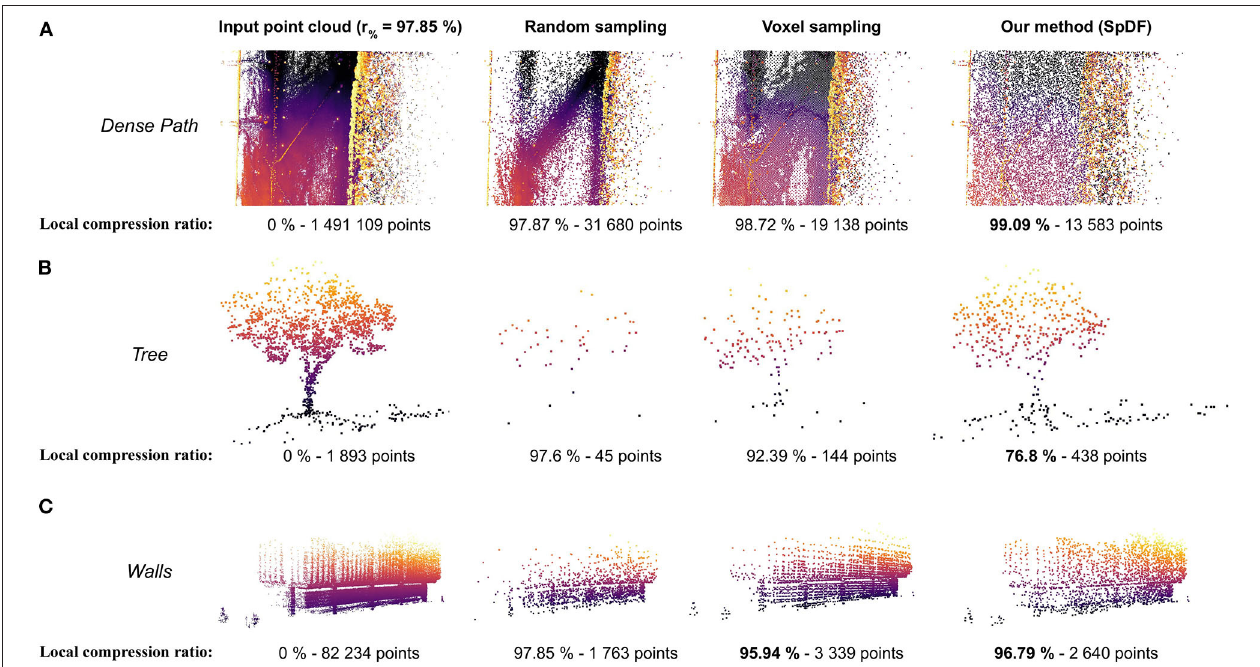
FIGURE 10 | Sub-views comparison from the Grand Axe map, containing more than 4.65 million points with varying densities. The whole point cloud has been sampled to 100 k points (i.e., a compression ratio of 97.85 %) by Random sampling, by Voxel sampling and by our method, SpDF . Local compression ratio has been reported for each sub-view. (A) Sub-view of a dense path containing a very high density of points. Random kept a lot of points and still presents varying densities. Voxel regularly sampled the path, but kept slightly more points as the ground is not aligned with the xy -plane. SpDF aggressively sampled the path, adapting then the local compression ratio up to 99 %, and have made the density uniform. (B) Sub-view of one tree. With Random , most of the points have been removed due to low local density and the tree is no longer distinguishable, while with SpDF , we efficiently sample the tree, reducing then the local compression ratio to 76.8 %, and keep the geometric information. Voxel kept slightly less points than SpDF , preserving less details. (C) Sub-view of structured walls. Random kept more points in the dense part of the wall, losing then the geometric information of the upper part. Voxel kept the more point, regularly sampled the walls but loose the original geometric details. It removed the structured elements with low density on the top-left, while our method, SpDF , kept points uniformly on the structure, reducing then the local compression ratio to 96.79